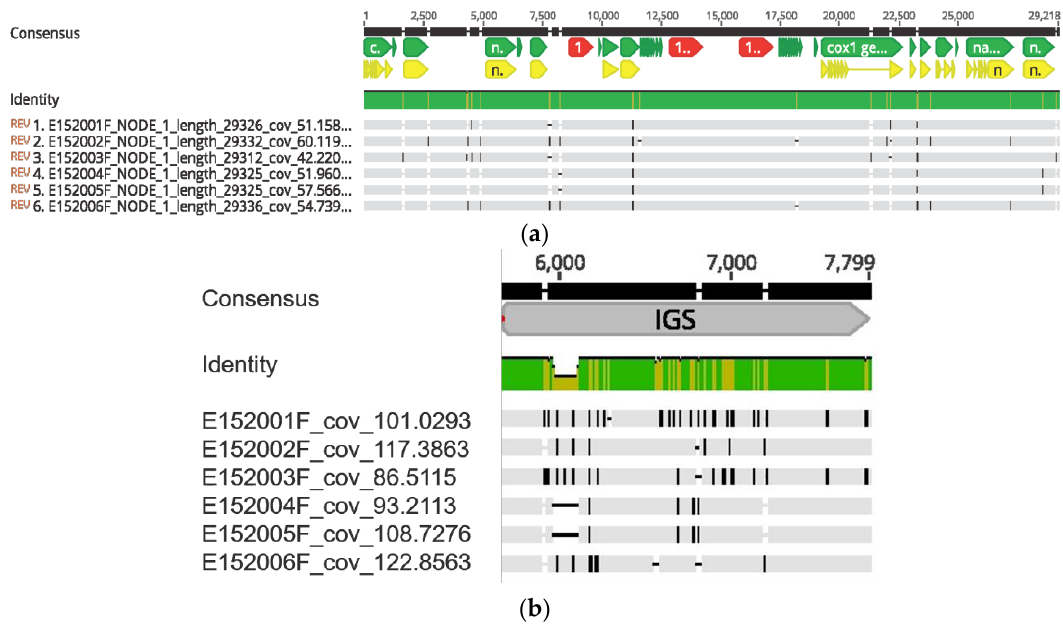
Figure 4. Aligned mitochondrial genome of the six A. flavus strains isolated from infected corn cob ( a ). Aligned IGS region of the ribosomal cluster of the six A. flavus strains isolated from infected corn cob ( b ).